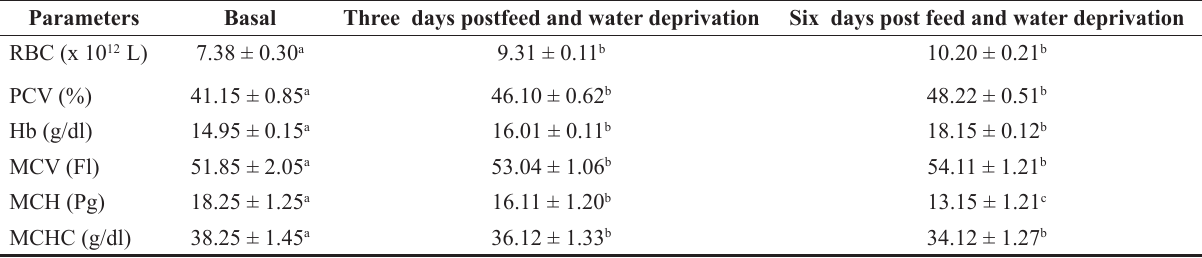
Values within the same rows with different superscripts are significantly different at p<0.05. RBC: Red blood cell; PCV: Packed cell volume; Hb: Haemoglobin; MCV: Mean corpuscular volume; MCH: Mean corpuscular haemoglobin; MCHC: Mean corpuscular haemoglobin concentration. Table 2: White blood and differentials in male rats deprived of feed and water for six consecutive days Parameters Basal